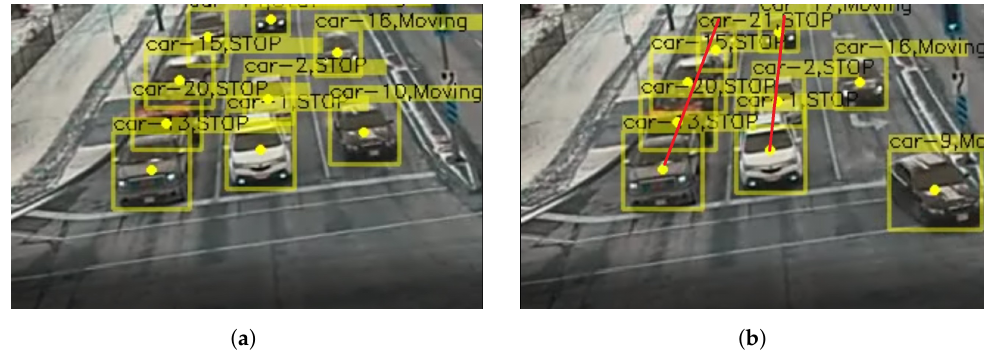
Figure 4. ( a ) Unique tracking ID assignment and identification of stopped vehicles, ( b ) Estimation of queue lengths after identification of stopped